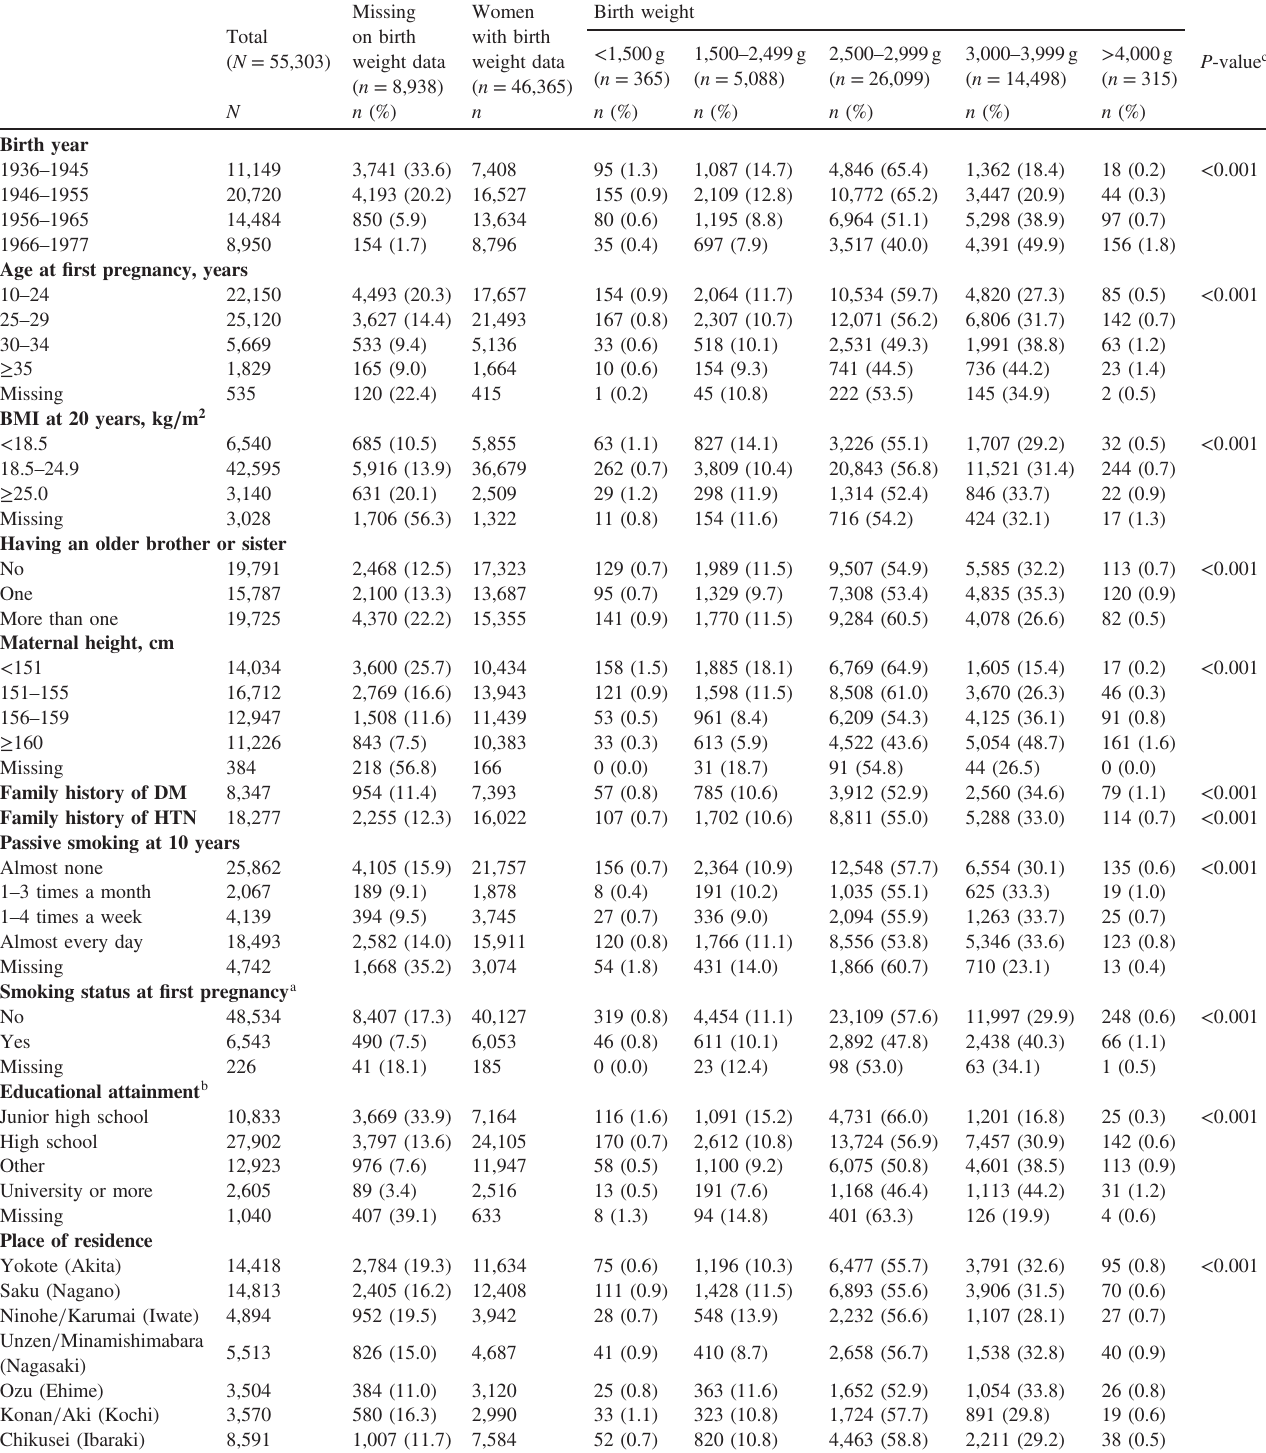
Table 1. Distribution of maternal demographics by categories of birth weight among women who had a pregnancy